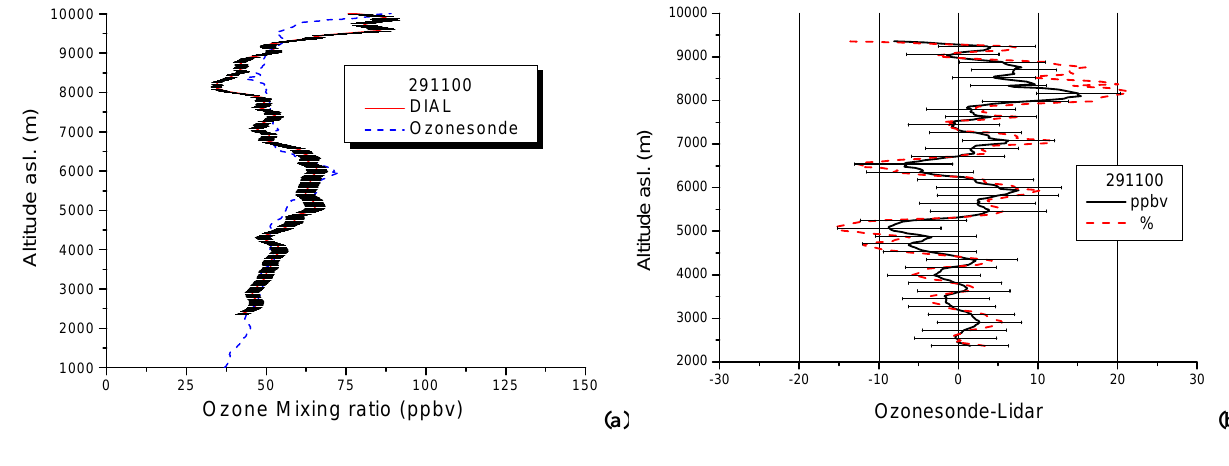
Fig. 1. (a) Ozone vertical profile measured by the AUTH DIAL system (solid line) and by the ECC-sonde (dashed line) on 29 November 2000 at 18:00 UT over Thessaloniki. (b) The relative difference between the ozone profiles derived from ozonesonde and lidar, as a function of altitude (in ppbv and %) on 29 November 2000 at 18:00 UT over